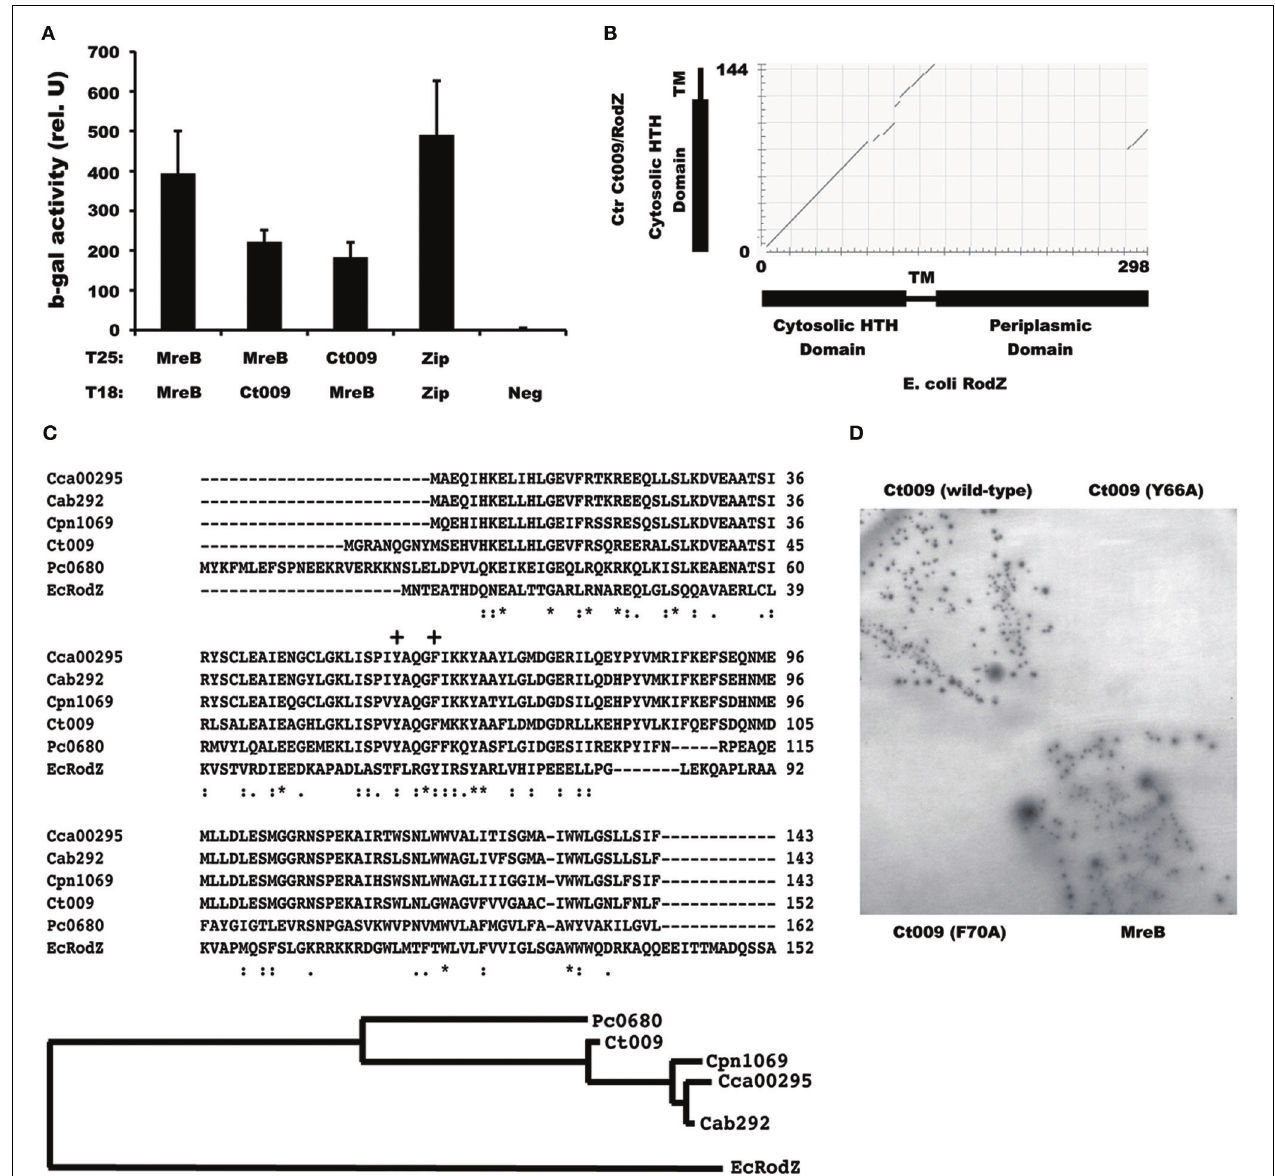
FIGURE 3 | Identification of a chlamydial rodZ homolog. (A) Interaction of chlamydial MreB with Ct009 in the BACTH GW system. A positive control of T25-Zip vs. T18-Zip is shown. The ß-galactosidase assays and negative controls are as described for Figure 1 . (B) Alignment of chlamydial Ct009/RodZ (y-axis) with E. coli RodZ (x-axis) with corresponding domains schematically represented. Note that the chlamydial RodZ homolog is missing the periplasmic domain. (C) ClustalW sequence alignment and phylogenetic relatedness of chlamydial Ct009 homologs, with corresponding